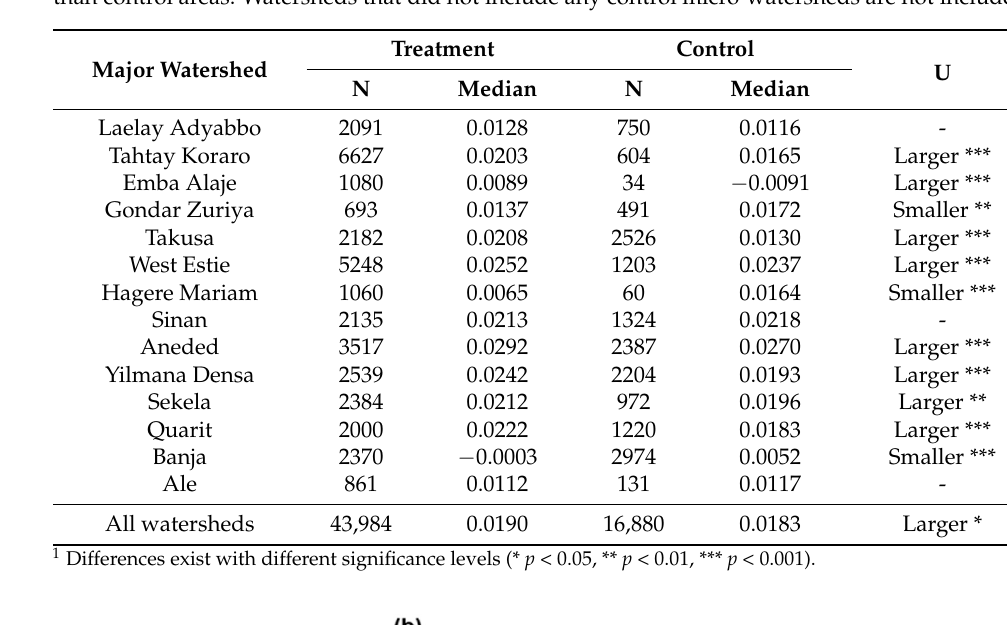
Table A2. Mann-Whitney U results with the sample size N (number of significant pixels), the median NDVI trend, and U indicating whether treatment areas have significantly 1 larger or smaller trends than control areas. Watersheds that did not include any control micro-watersheds are not included.